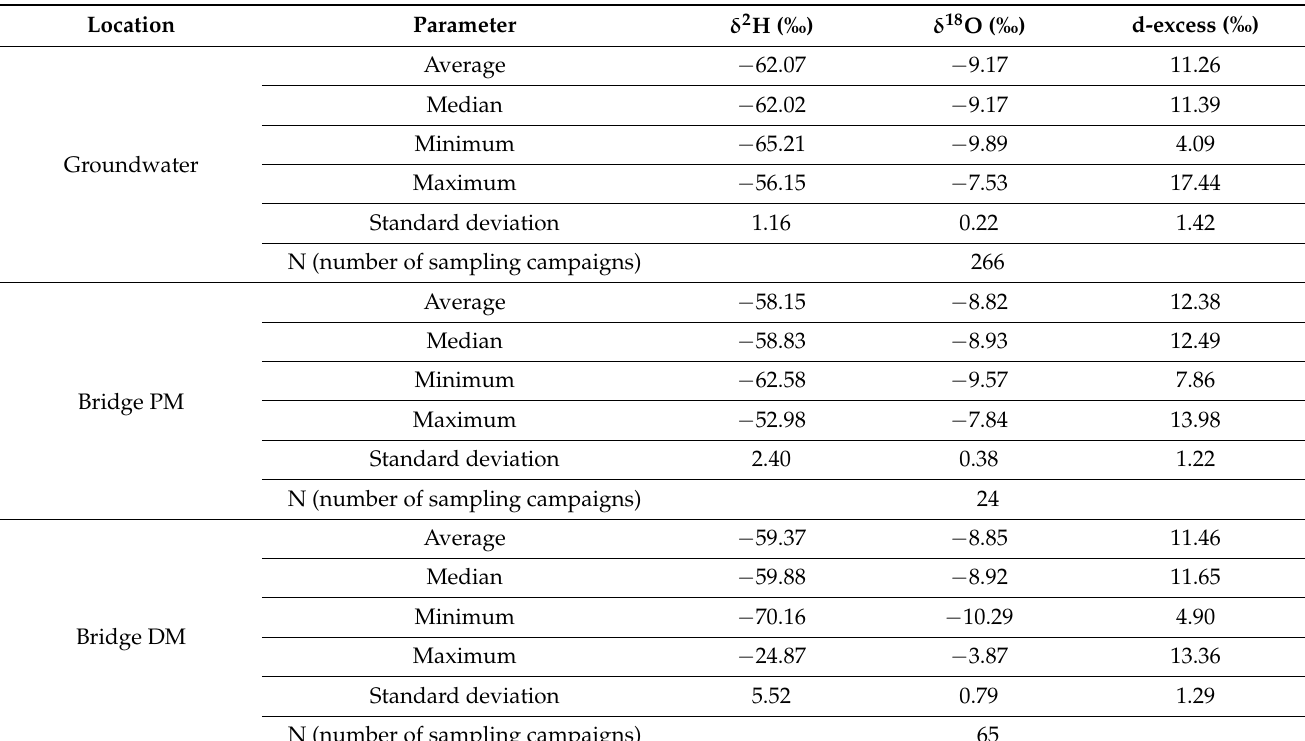
Table 2. Basic statistical values of isotope composition of groundwater and the Sava River in the area of the Zagreb